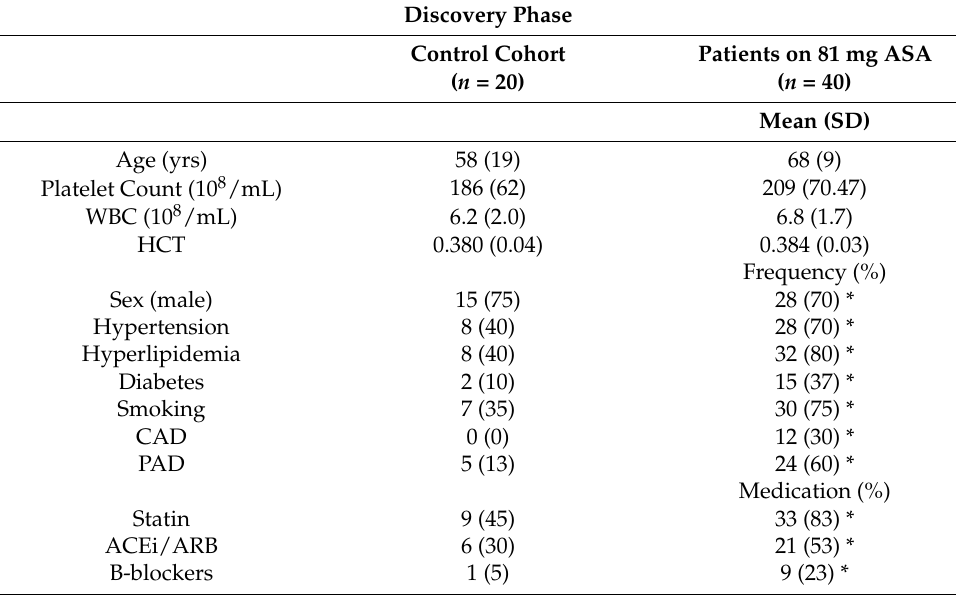
Table 1. Baseline characteristics of patients recruited to the discovery